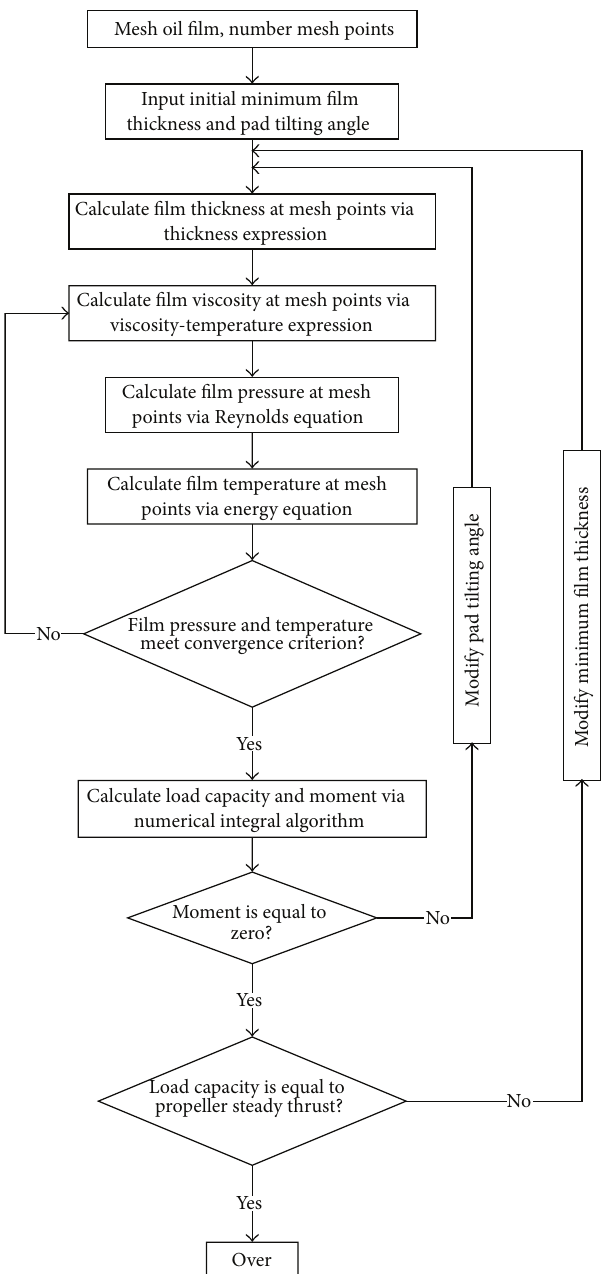
Figure 22: Calculation flow chart of hydrodynamic